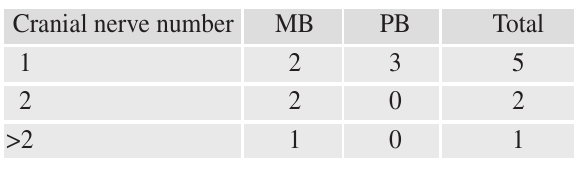
Table VI: Number of cranial nerves involved in leprosy subjects! !